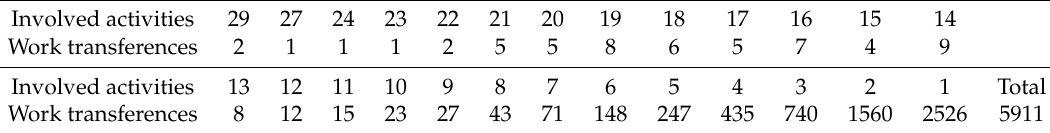
Table 2. Numbers of different cases of work transferences and their involved